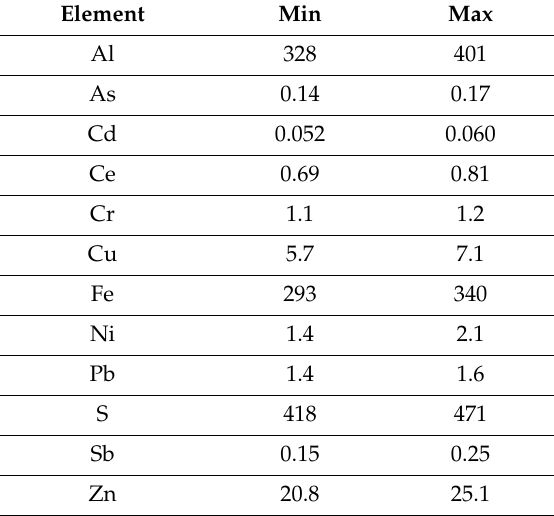
Table 3. Ranges (95% confidence intervals) of estimated average annual element deposition rates (kg · km − 2 · y − 1